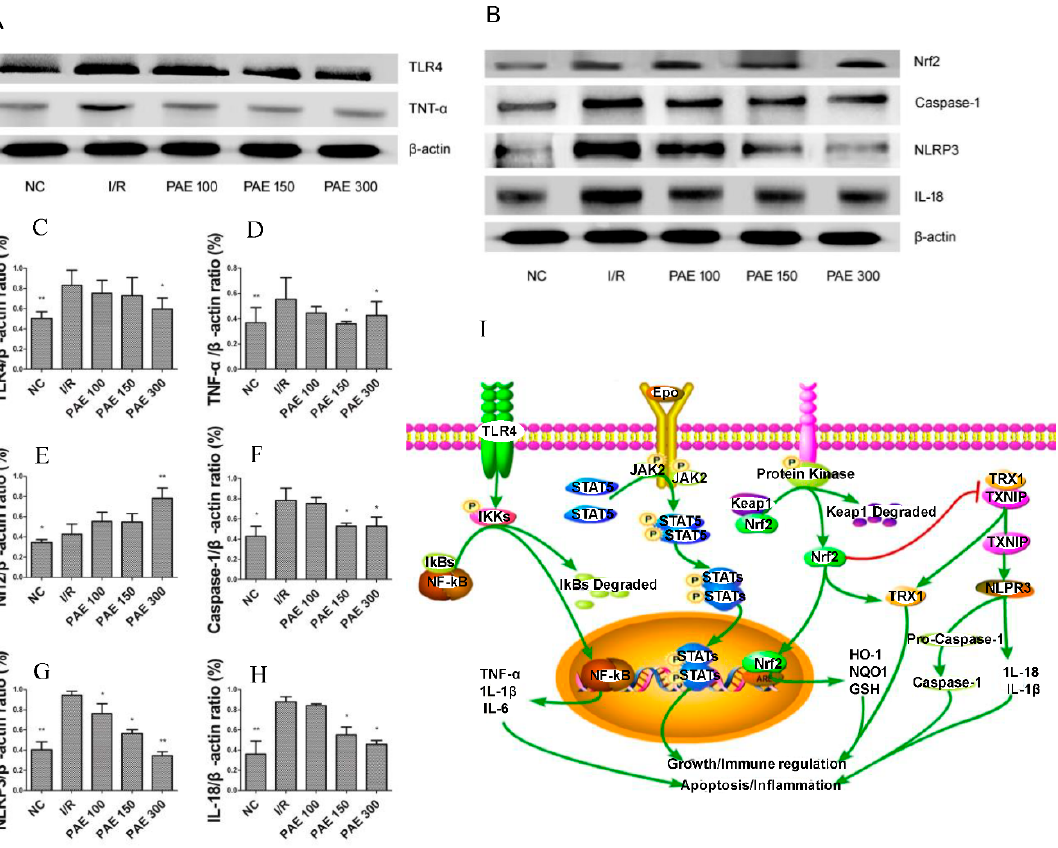
Figure 7. Effect of PAEs from Dongkui Myrica rubra on protein expression: ( A ) the expressions of Toll-like receptor 4 (TLR4), tumor necrosis factor alpha (TNF- α ), and β -actin; ( B ) the expressions of nuclear erythroid 2-related factor 2 (Nrf2), caspase-1, NOD-like receptor pyrin domain-containing 3 protein (NLRP3), IL-18, and β -actin. The quantifications of ( A ) and ( B ) are shown in ( C – H ). All of the data are shown as mean ± SD ( n = 10); * p < 0.05, ** p < 0.01 vs. I/R group. ( I ) The signal pathways; ↑ represents activation, while T (red line) represents